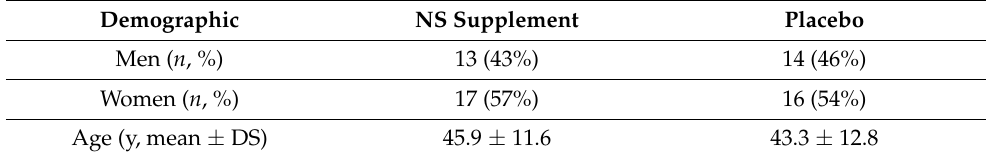
Table 1. Subjects’ characteristics at